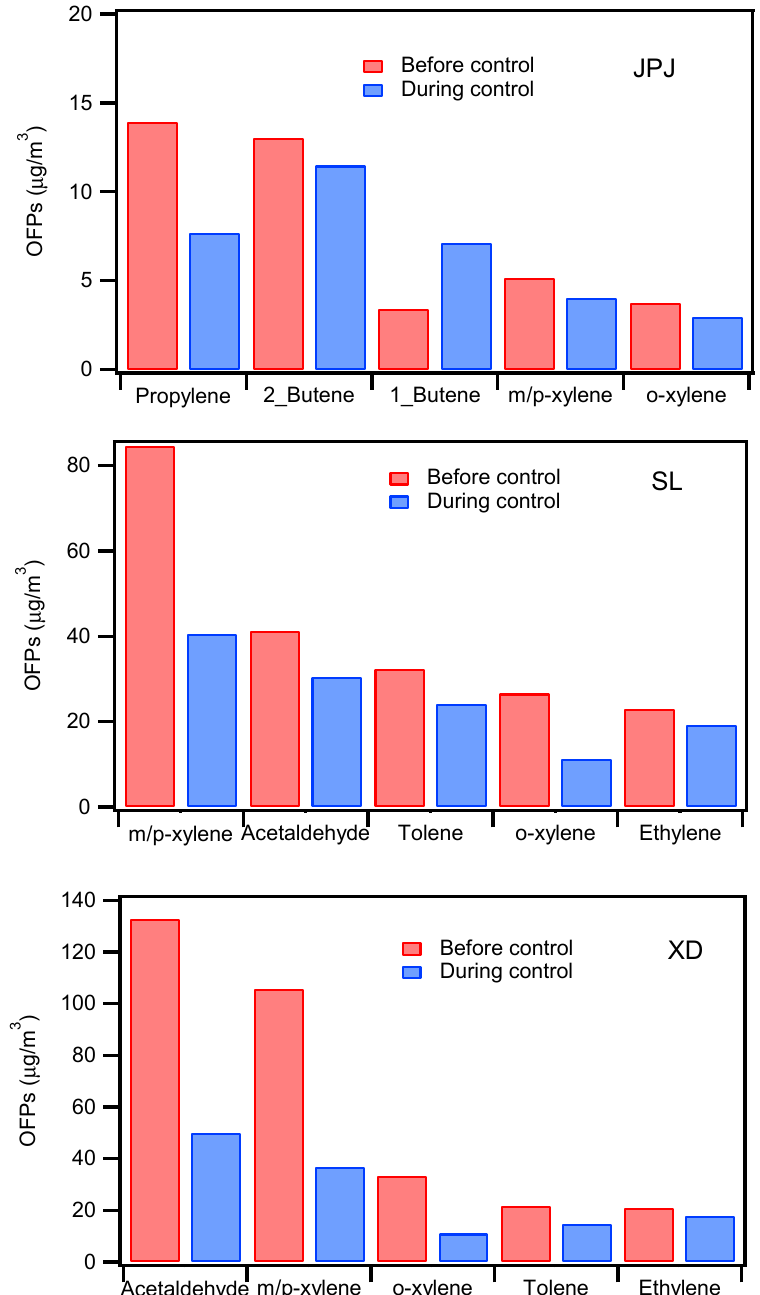
Figure 7. Top five VOC species and their contribution to OFPs at each study site. (Red bar: before control; Blue bar: during control).